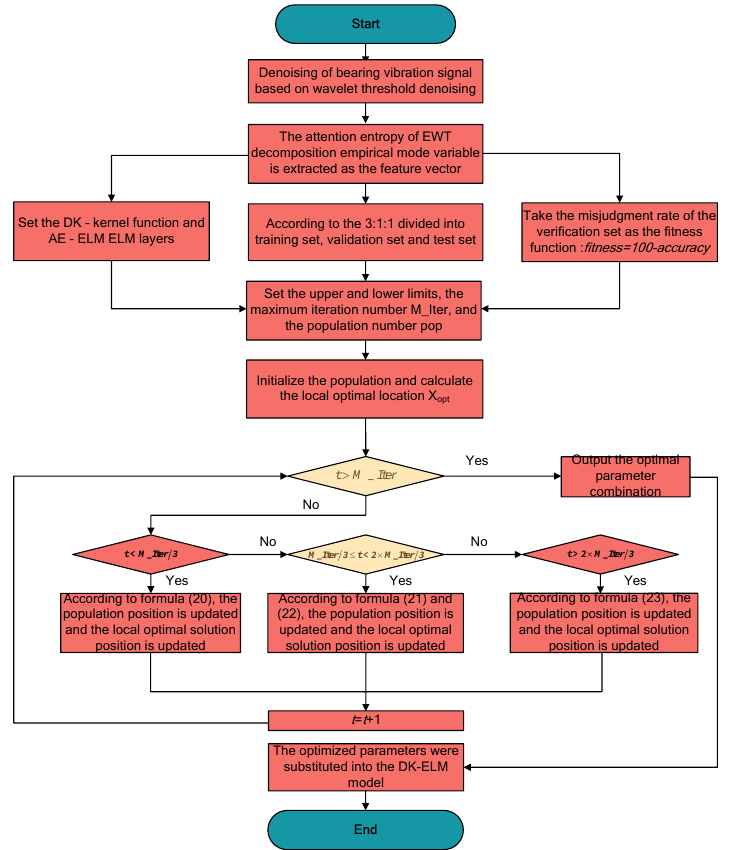
Figure 3. The flow chart of proposed diagnostic method of rolling